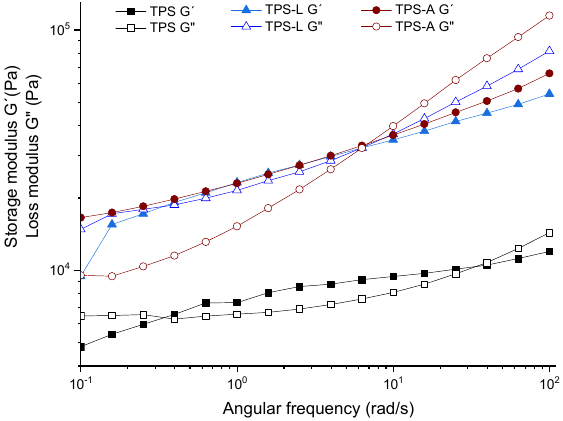
Figure 1. Dynamic rheological properties of TPS samples.